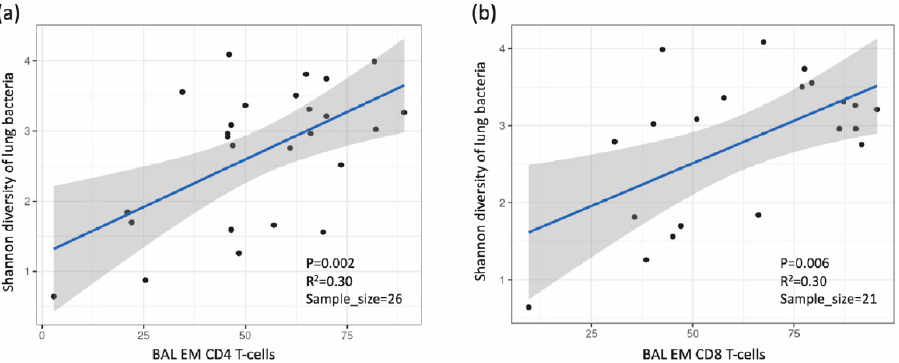
Figure 7. Relationship between microbial diversity vs. ( a ) CD4+ and ( b ) CD8+ BAL EM T-cells. 3.5. Association between Lung Microbiota and HIV Reservoir Size within the Lungs We found a negative relationship between lung bacterial diversity and HIV-DNA levels in PBMC (Linear regression, estimate = − 0.002, p = 0.029), while no relationship was detected between bacterial diversity and HIV-DNA in BAL ( p = 0.61) (data not shown). The HIV-DNA levels in PBMC also had a significant impact on the community composi- tion of lung bacteria (ANOVA test on distance-based redundancy analysis, F = 1.22, p = 0.02, Figure 8) while that in BAL did not (F = 0.8, p = 0.89). Moreover, higher levels of HIV-